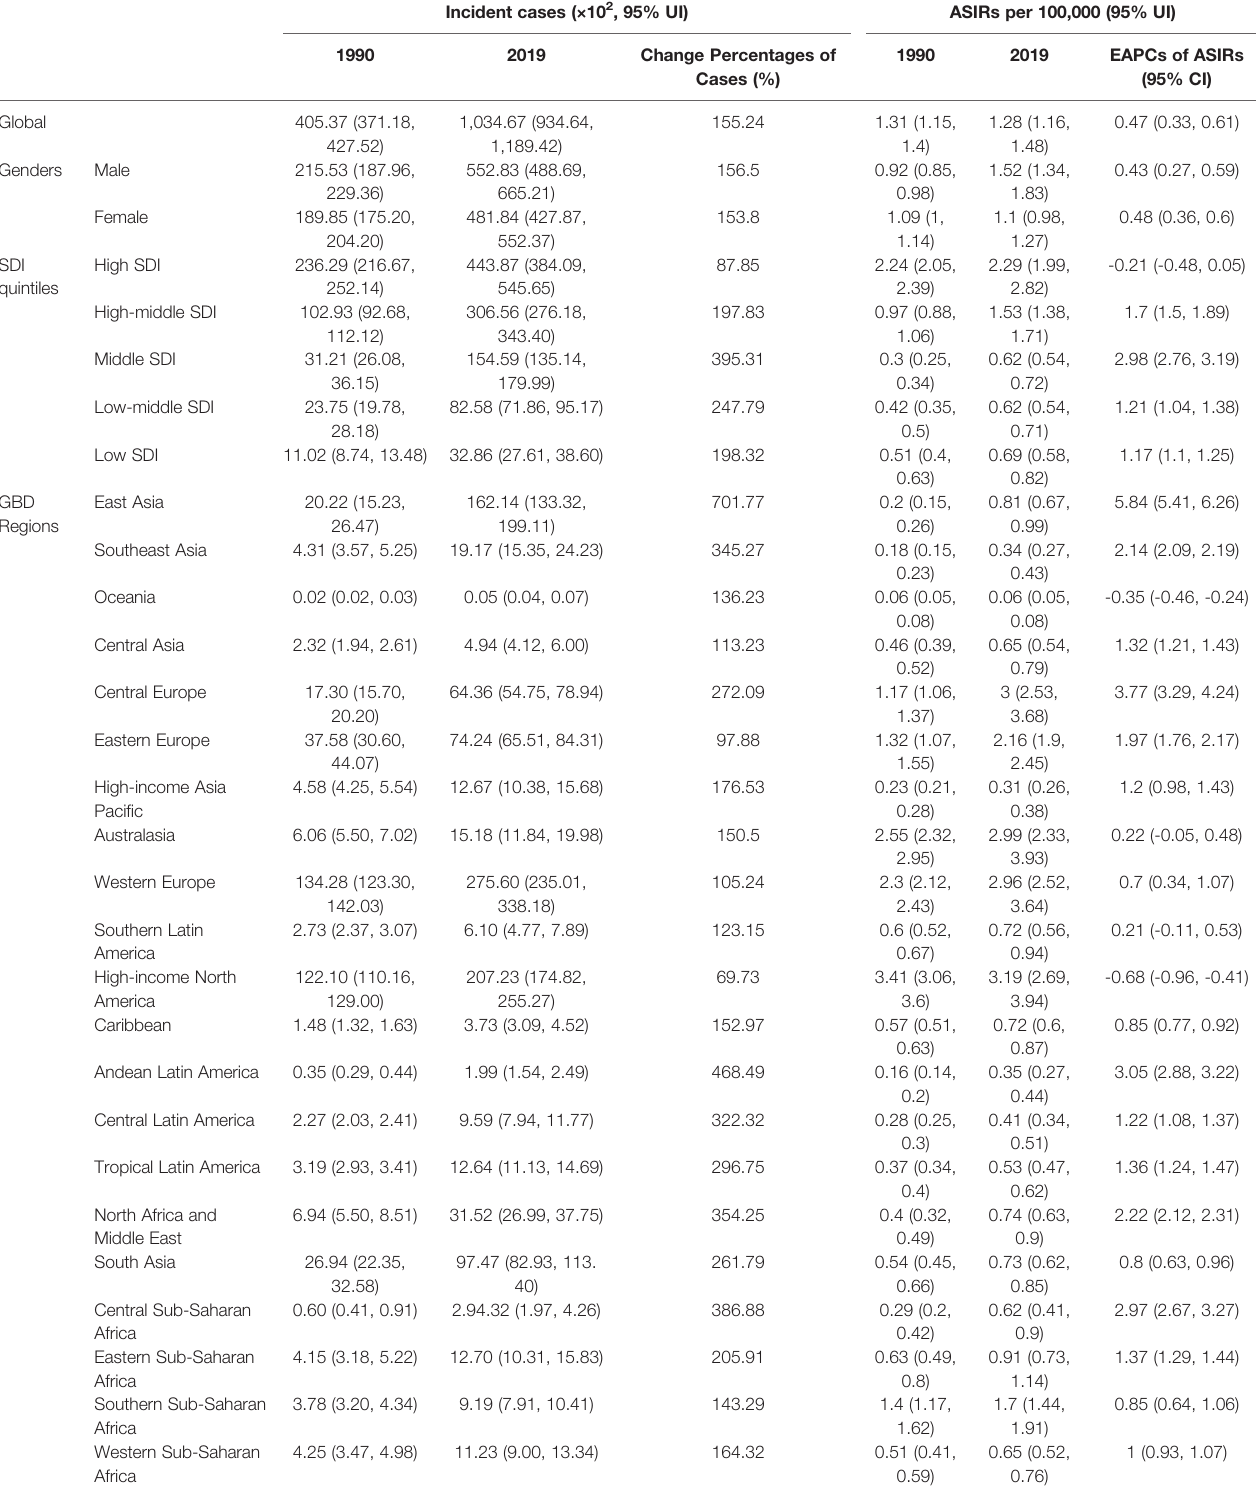
TABLE 1 | The incident cases and ASIRs of CLL in 1990 and 2019, and the trends from 1990 to